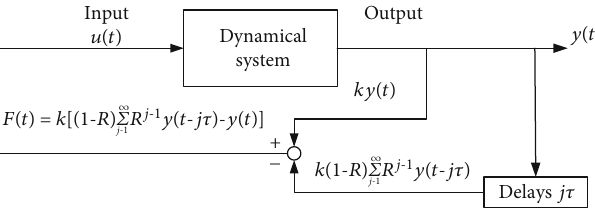
Figure 9: Basic block chart of the ETDAS control